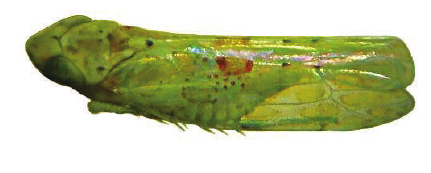
Figure 1: Dikrella caryocar n. sp, male: habitus (latero